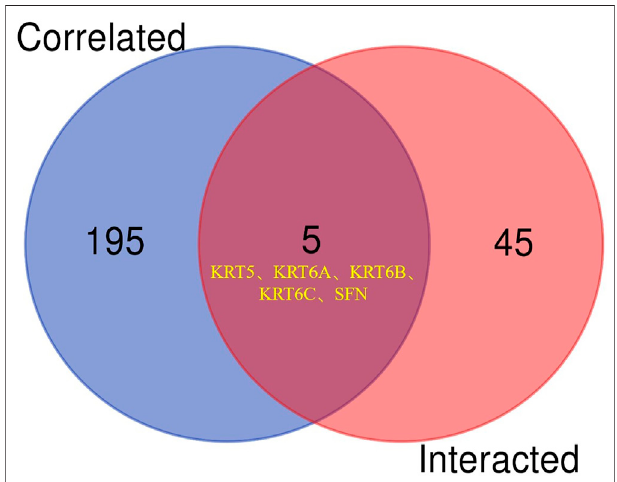
FIGURE 12 | Cross analysis of KRT17 binding protein and related genes. An intersection analysis of the abovementioned two groups showed fi ve common members, namely, KRT5, KRT6A, KRT6B, KRT6C and